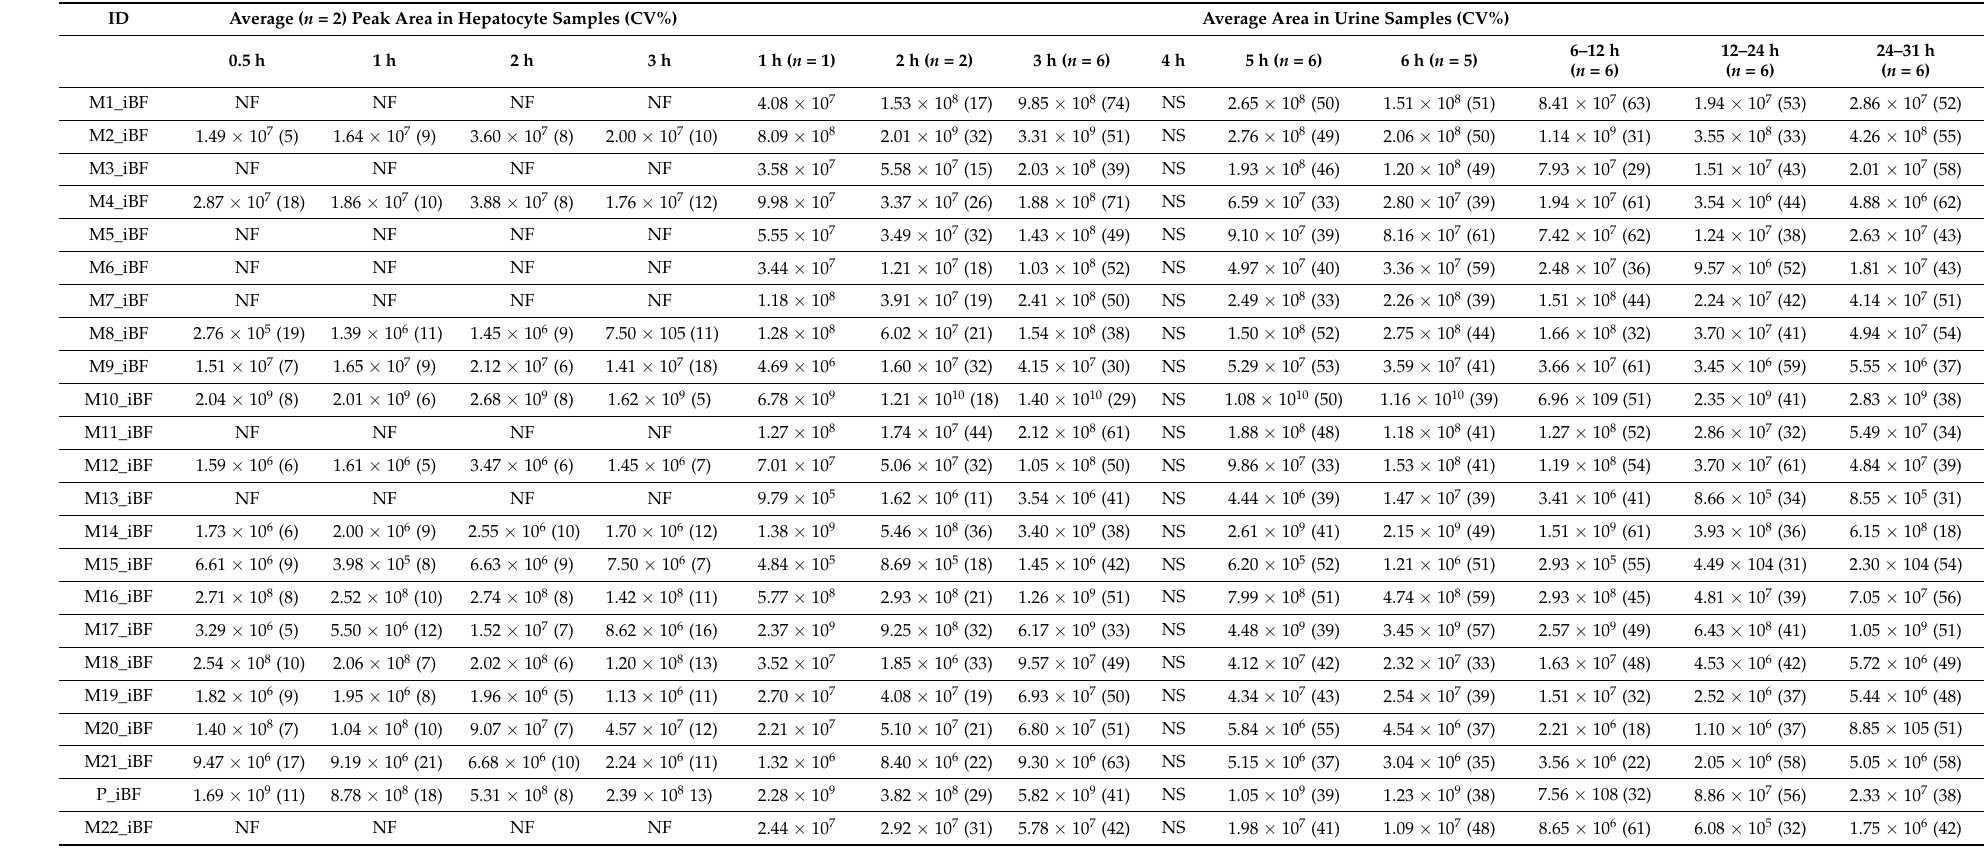
Table 4. Results of the in vitro and in vivo studies for